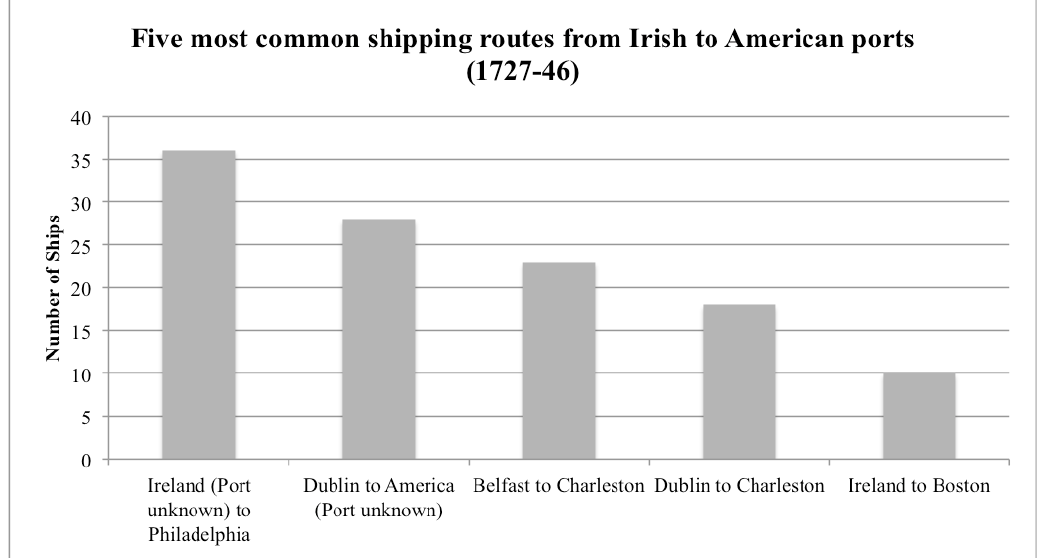
Figure 2. Five most common shipping routes from Irish to American ports